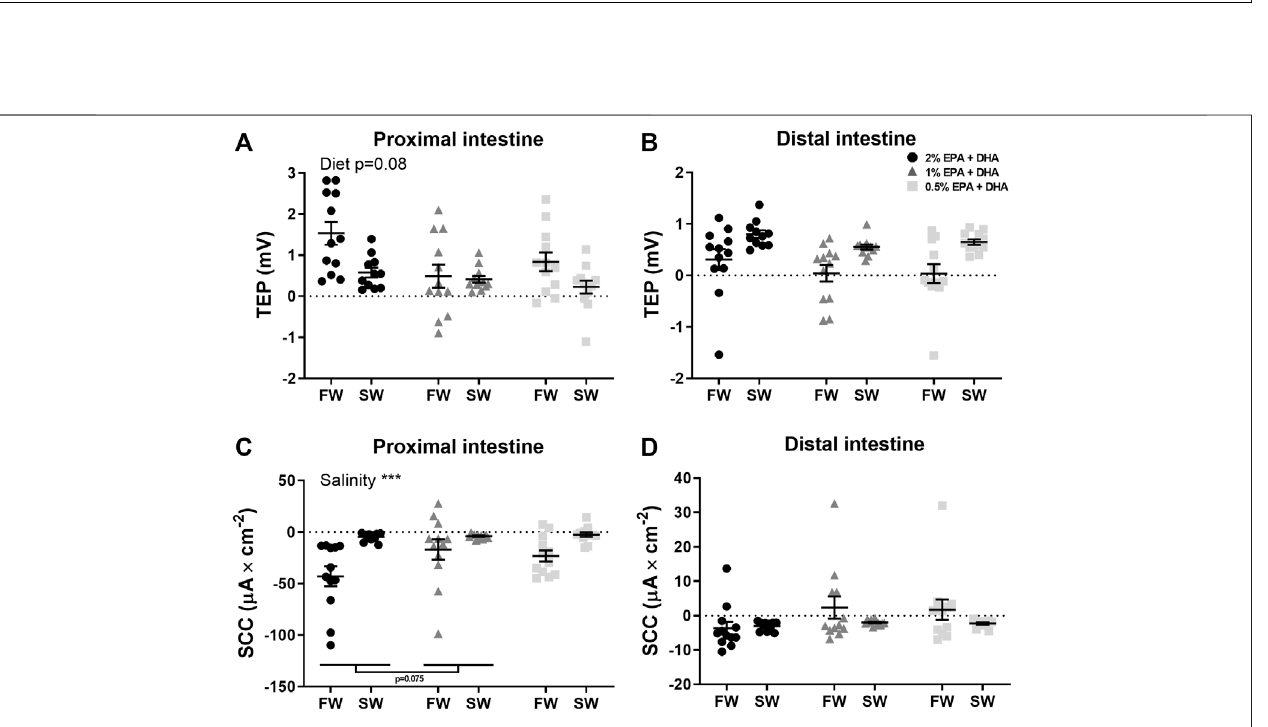
Frontiers in Physiology |